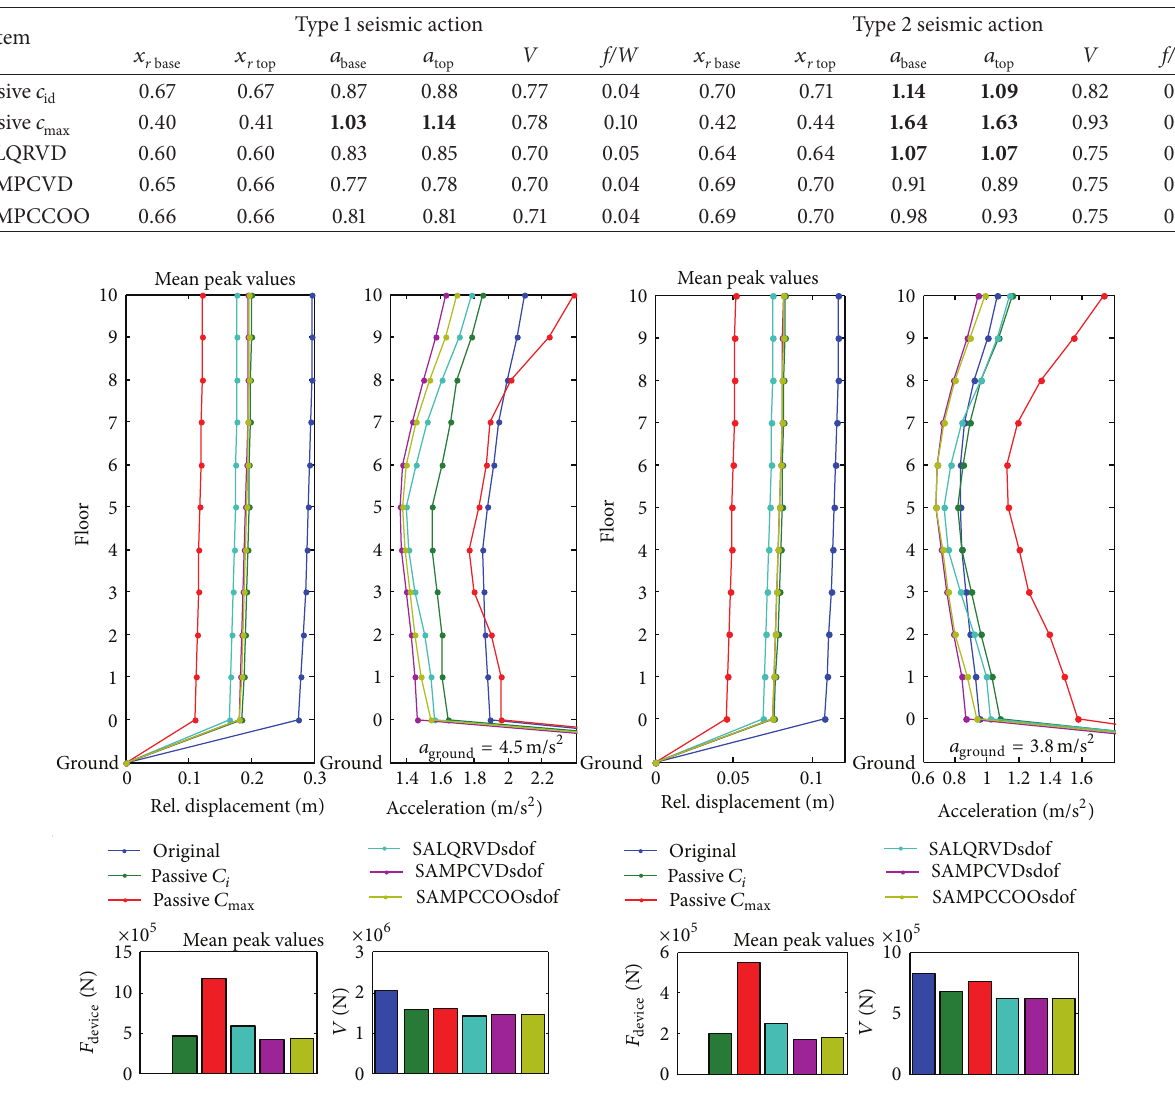
Figure 11: 10-storey base-isolated building responses to 10 type 1 and type 2 accelerograms. Mean peak values in terms of relative displace- ments, accelerations, base shear 𝑉 , and device’s force 𝑓 for the systems under study.